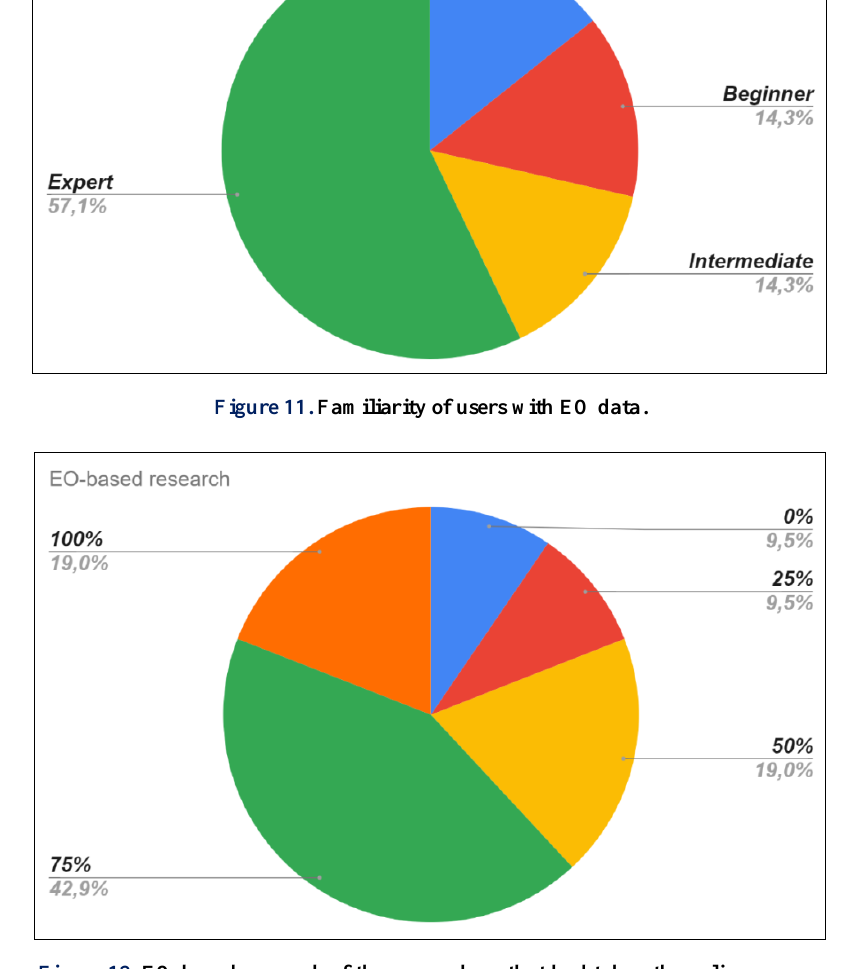
Figure 12. EO-based research of the researchers that had taken the online survey.